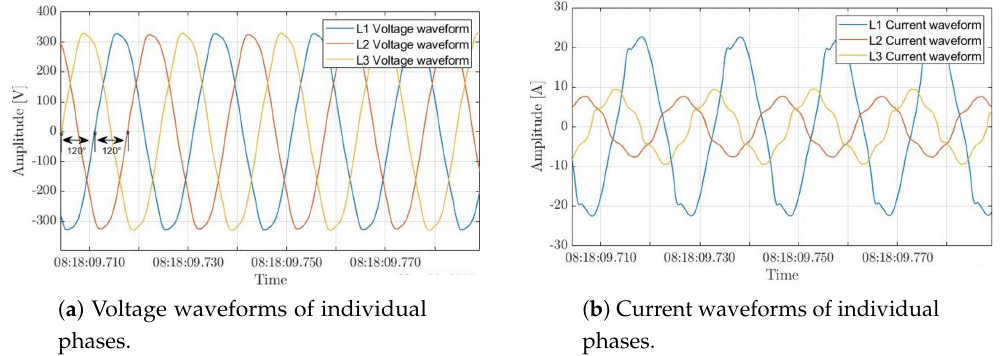
Figure 15. Snippets of voltage and current waveforms acquired by the three-phase IMPEC system in an industrial setting over a period of 7days.